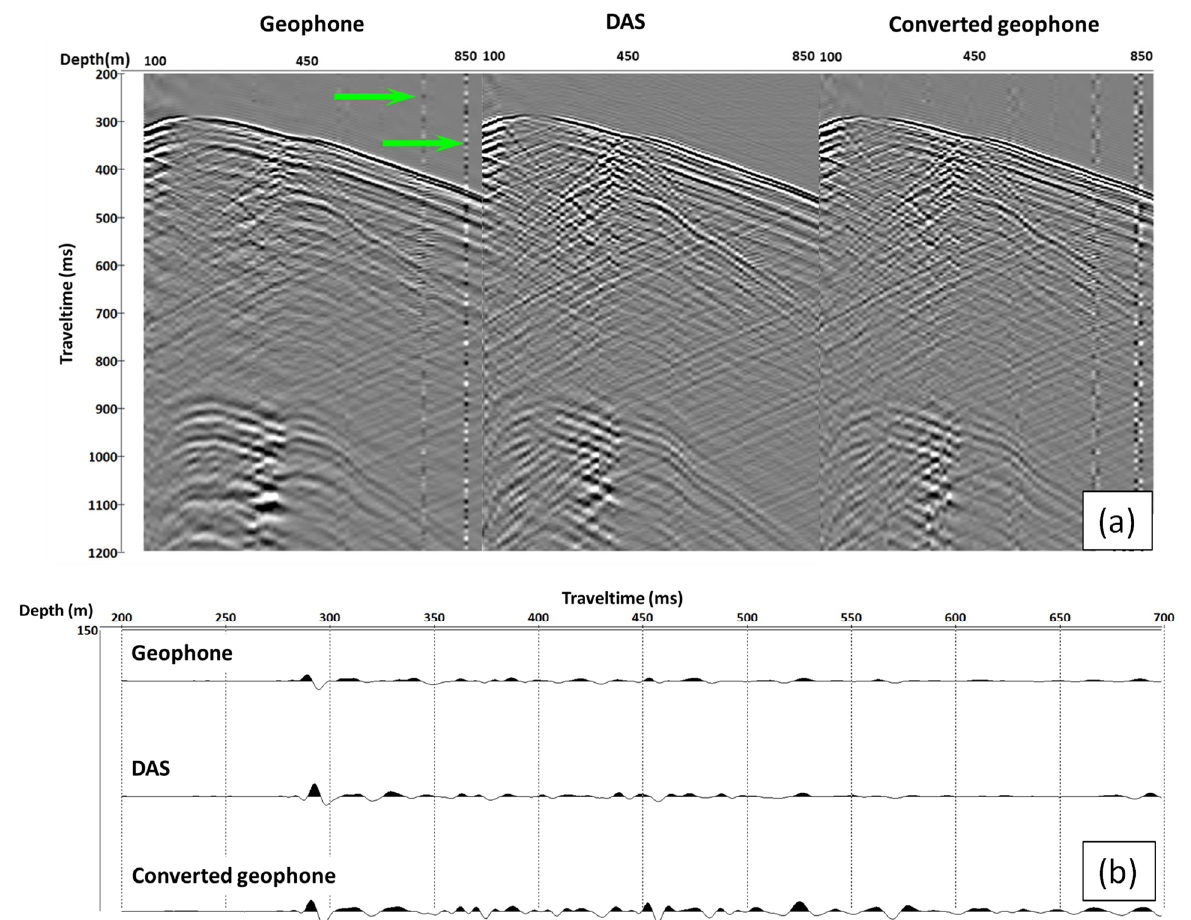
Figure 5. Far offset example: ( a ) gathers of geophone, DAS and converted geophone response; ( b ) trace at a depth of 150 m of geophone, DAS and converted geophone response. We exclude every second trace from DAS data to match the same receiver interval for geophone/converted geophone and DAS. The green arrows indicate locations of malfunctioning geophones.